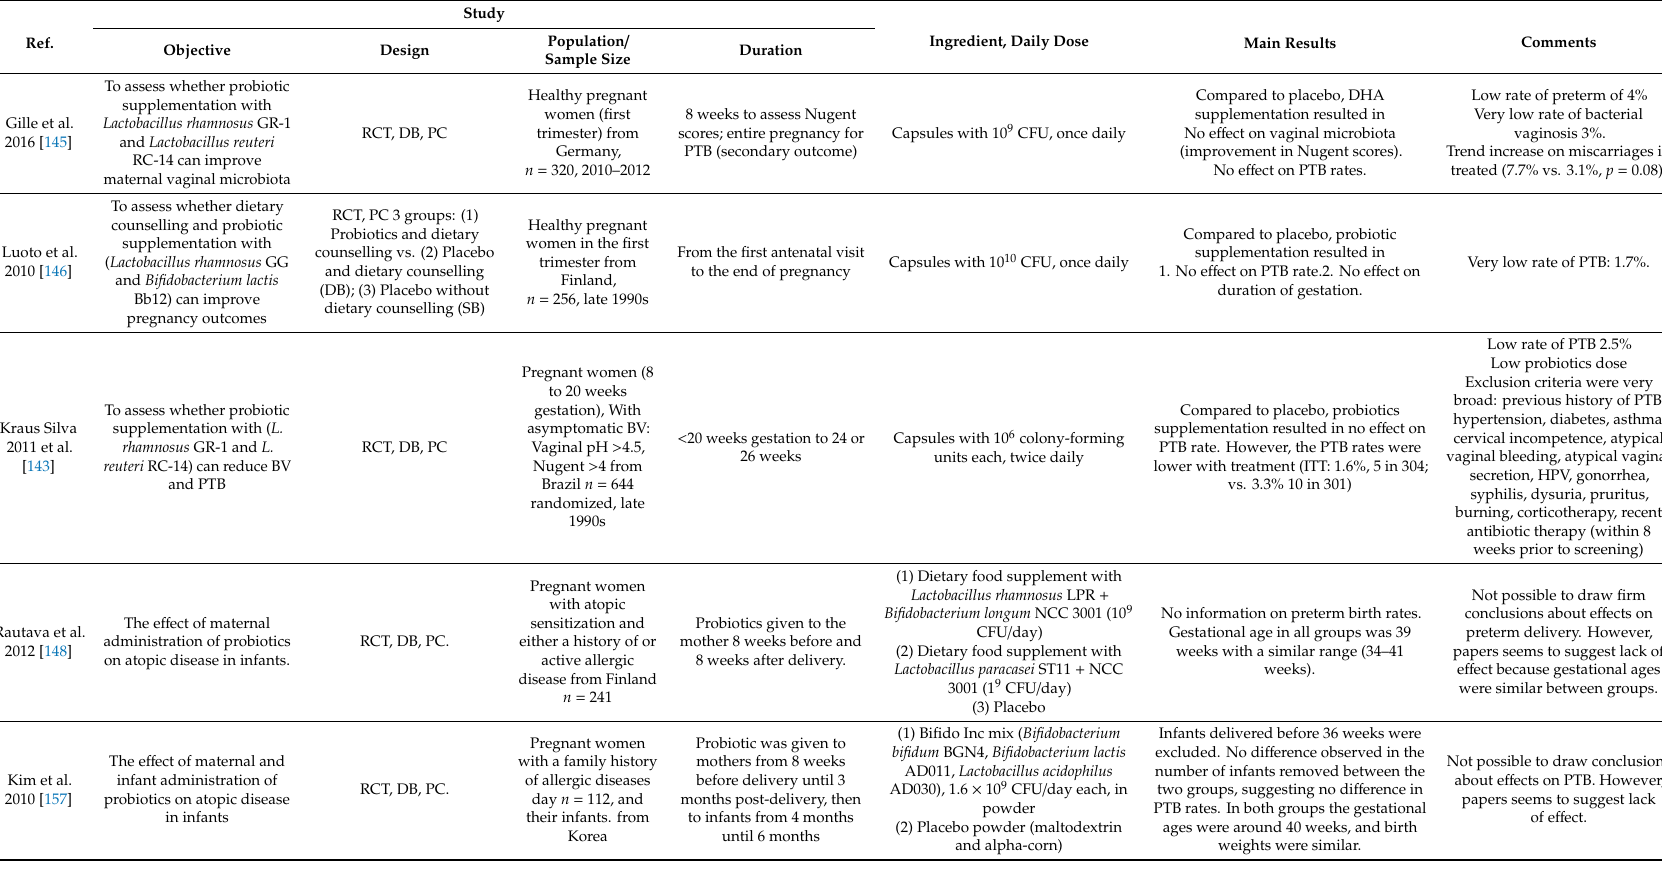
Table 2. Characteristics, e ffi cacy and safety of clinical trials investigating the role of probiotics in reducing risk of any preterm delivery.